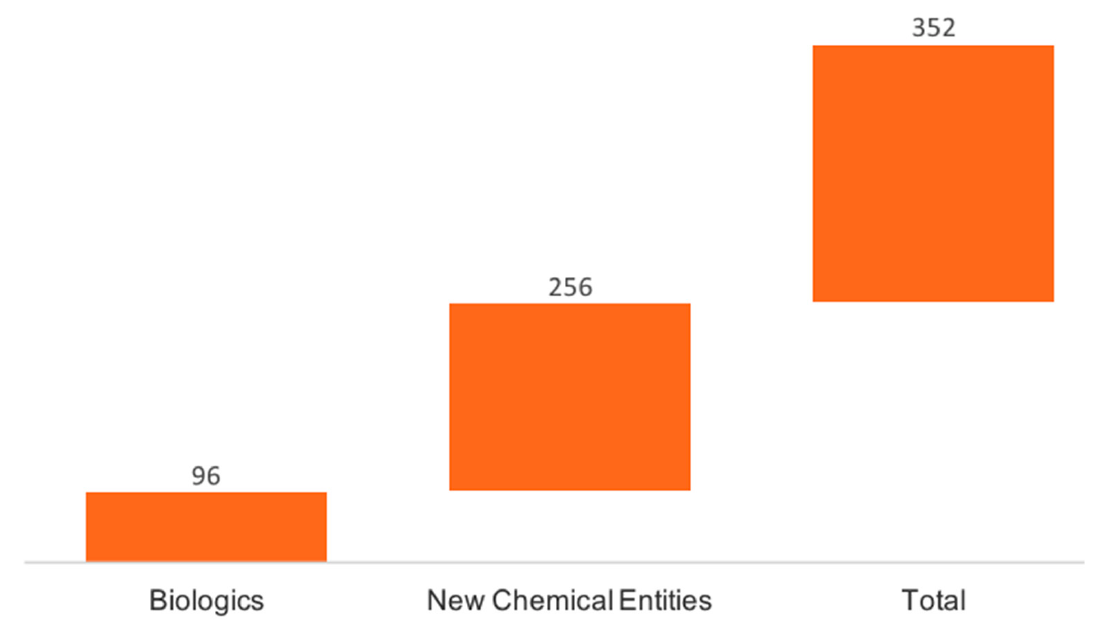
Figure 4. The US FDA approved drugs since 2014.